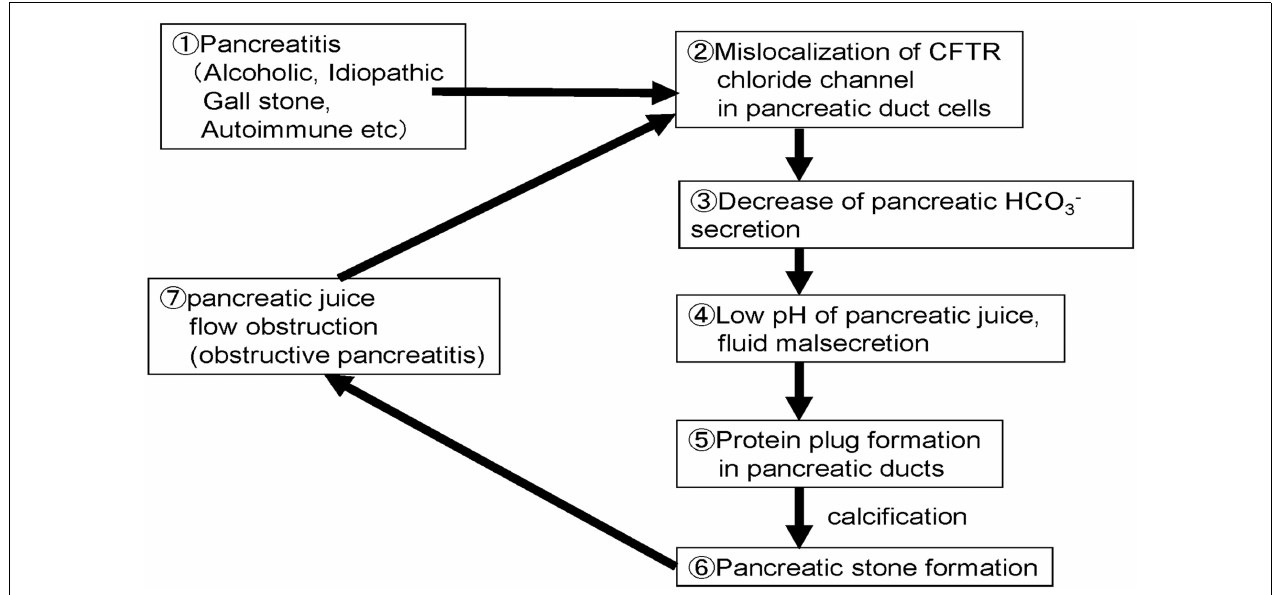
FIGURE 6 | Proposed cellular mechanisms of pancreatic stone formation in chronic